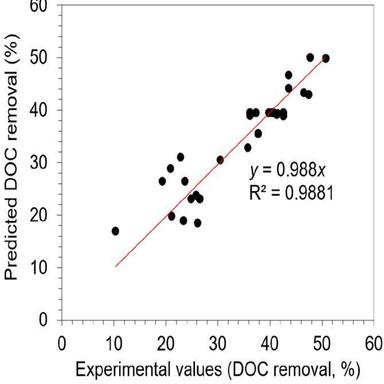
Experimental values versus the model predicted values on the mineralization efficiencies of EfOM in the IPWTP secondary effluents by Fenton oxidation process.